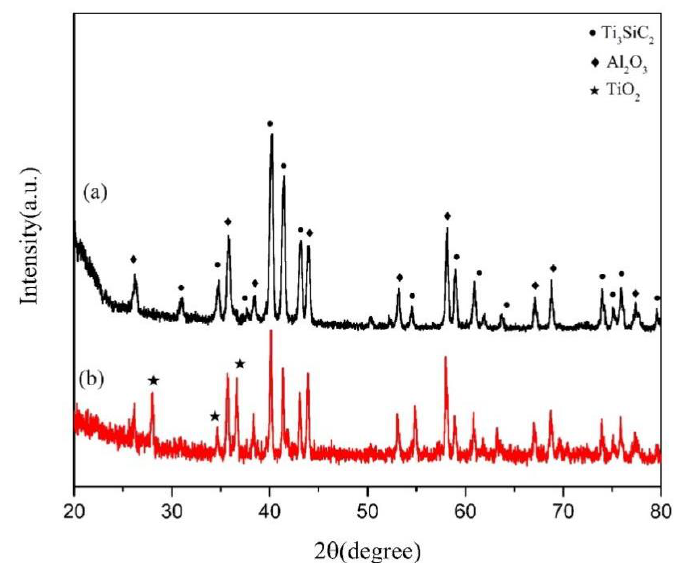
Figure 2. X-ray diffraction patterns of the TSC50 (a) before oxidation and (b) after oxidation at 1400 °C for 4 h.